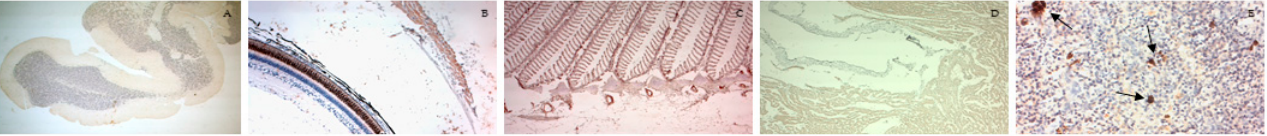
Figure 4. Pictures show the positivity (brownish color) of TRPV1 receptors in the brain ( A ), eye ( B ), gill ( C ), myocardium ( D ) and spleen ( E ). Black arrows indicate the melano-macrophages. Magnification: A 2.5×, B 10× C and D 5×, E 40×.